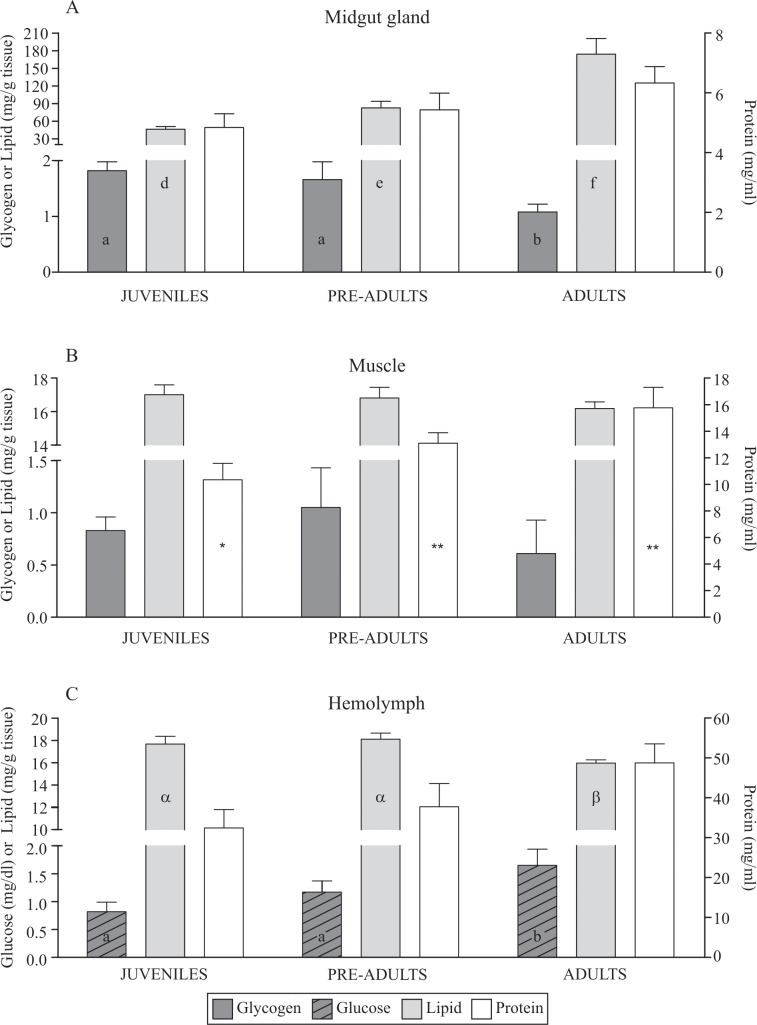
Glycogen, glucose, lipid, and protein concentrations of the midgut gland (A), muscle (B) and hemolymph (C) of Lithodes santolla at different ontogenetic stages. Different letters (a, b or α, β, χ) and asterisks (single or double) indicate statistical differences among ontogenetic stages (p<0.05).